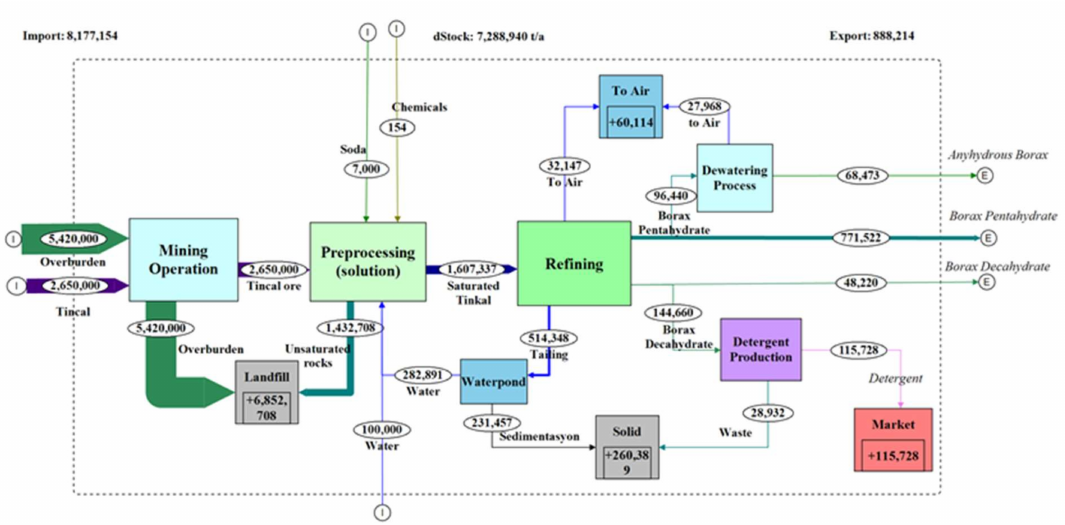
Figure 8. Tincal ore MFA model structure and respective flows are shown in the Sankey diagram.